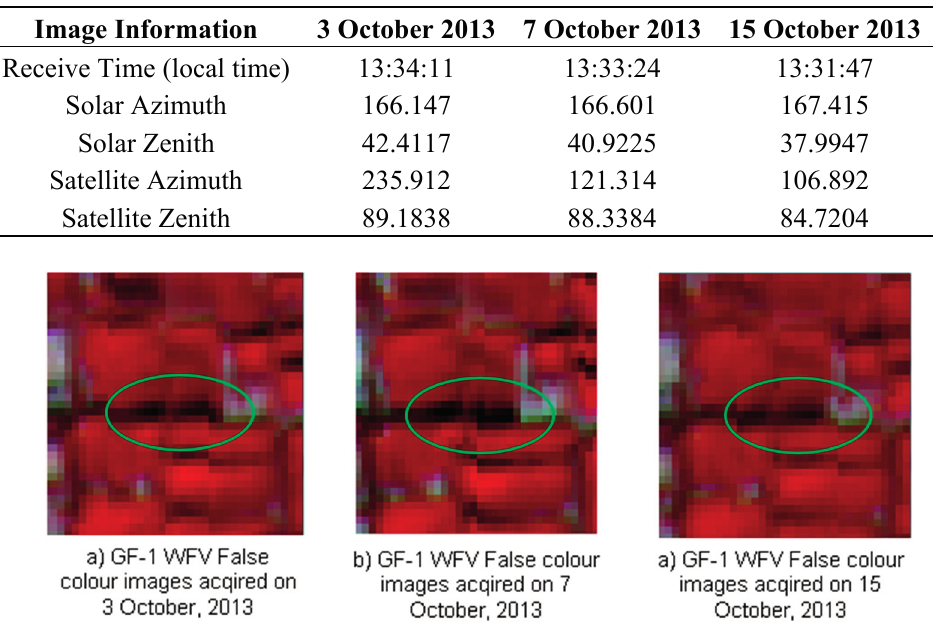
Table 9. Sensors and solar azimuth information from GF-1 WFV data.